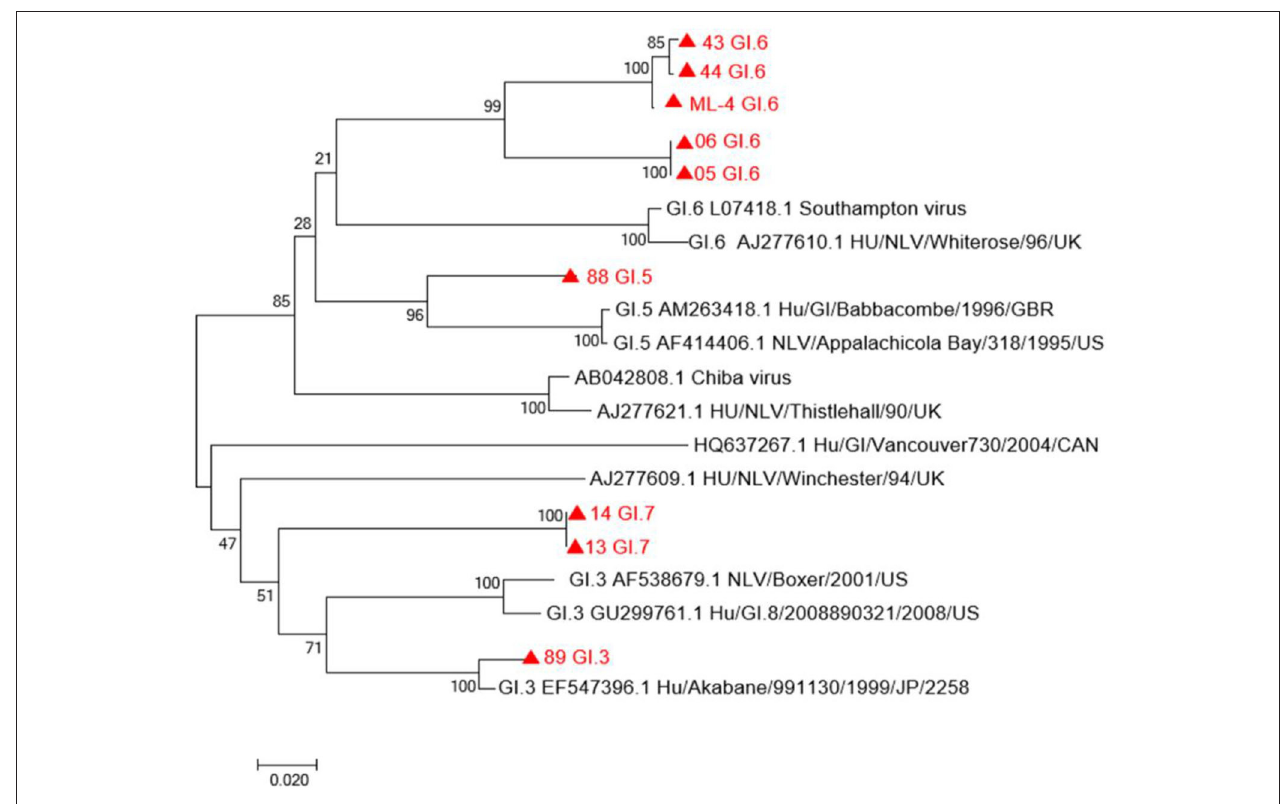
FIGURE 2 | A phylogenetic tree of GI sequence in oysters and patients with diarrhea in Yantai, China. Virus strains indicated by are from